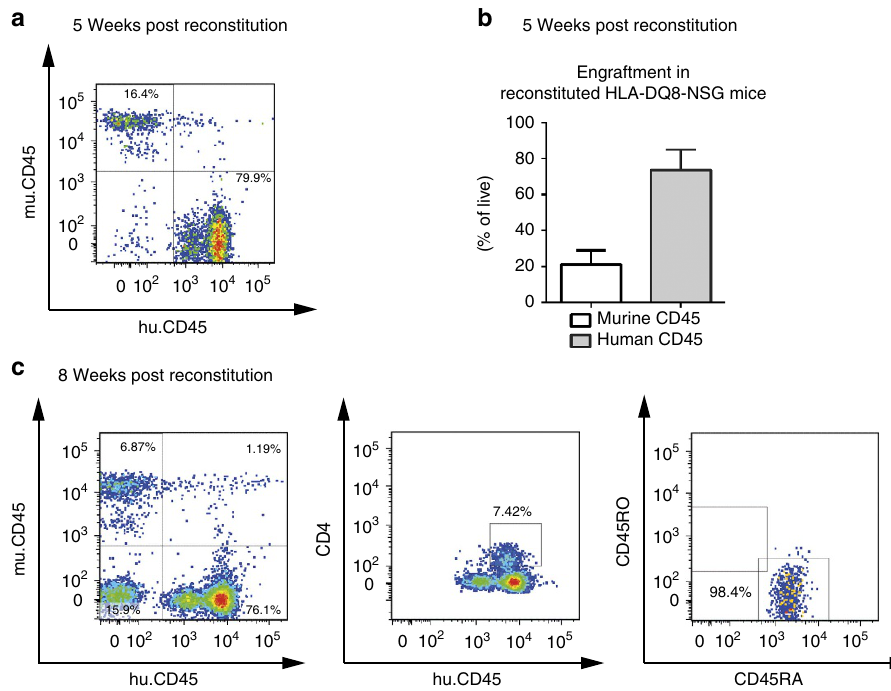
Figure 7 | Engraftment efficiency of reconstituted NSG-HLA-DQ8 transgenic mice. ( a ) NSG-HLA-DQ8 mice that had been reconstituted with human HSCs at 2 weeks after birth were first analysed for the engraftment of a human immune system 5 weeks later in peripheral blood. A representative FACS plot is shown to assess engraftment efficiency based on murine versus human CD45 expression levels. ( b ) Summary graphs for identified murine versus human CD45 þ cells in peripheral blood five weeks after reconstitution; n ¼ 8 from two independent experiments. ( c ) Representative set of FACS plots 8 weeks post engraftment to confirm human immune cell subsets based on murine versus human CD45 as assessed in peripheral blood. Human CD4 and activation status of human CD4 þ T cells using CD45RA and CD45RO